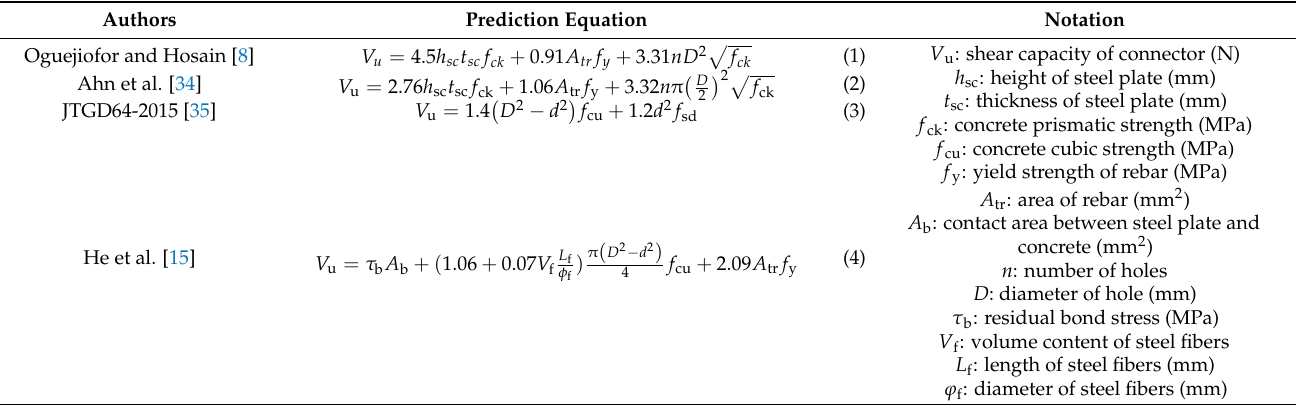
Table 3. Typical prediction formulas for the shear capacity of